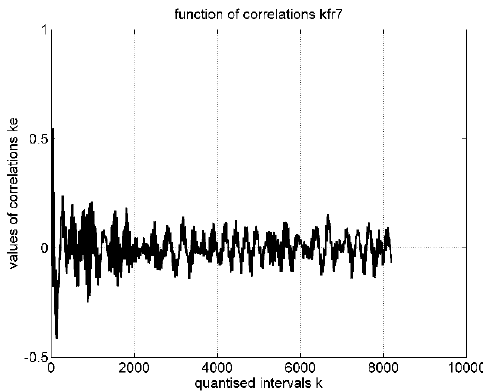
Figure 7. Normalized auto-covariance function of the 7th vibration accelerations vector.